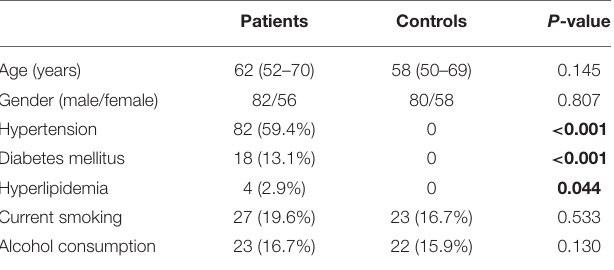
TABLE 1 | Comparisons of demographic data and vascular risk factors between controls and patients with acute intracerebral hemorrhage.